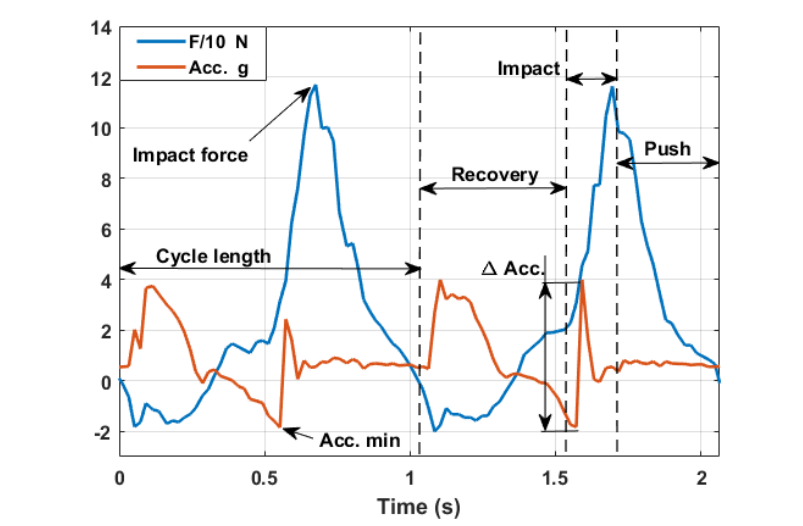
Figure 11. Acceleration-force comparison. Table 2. Inertia constant statistical